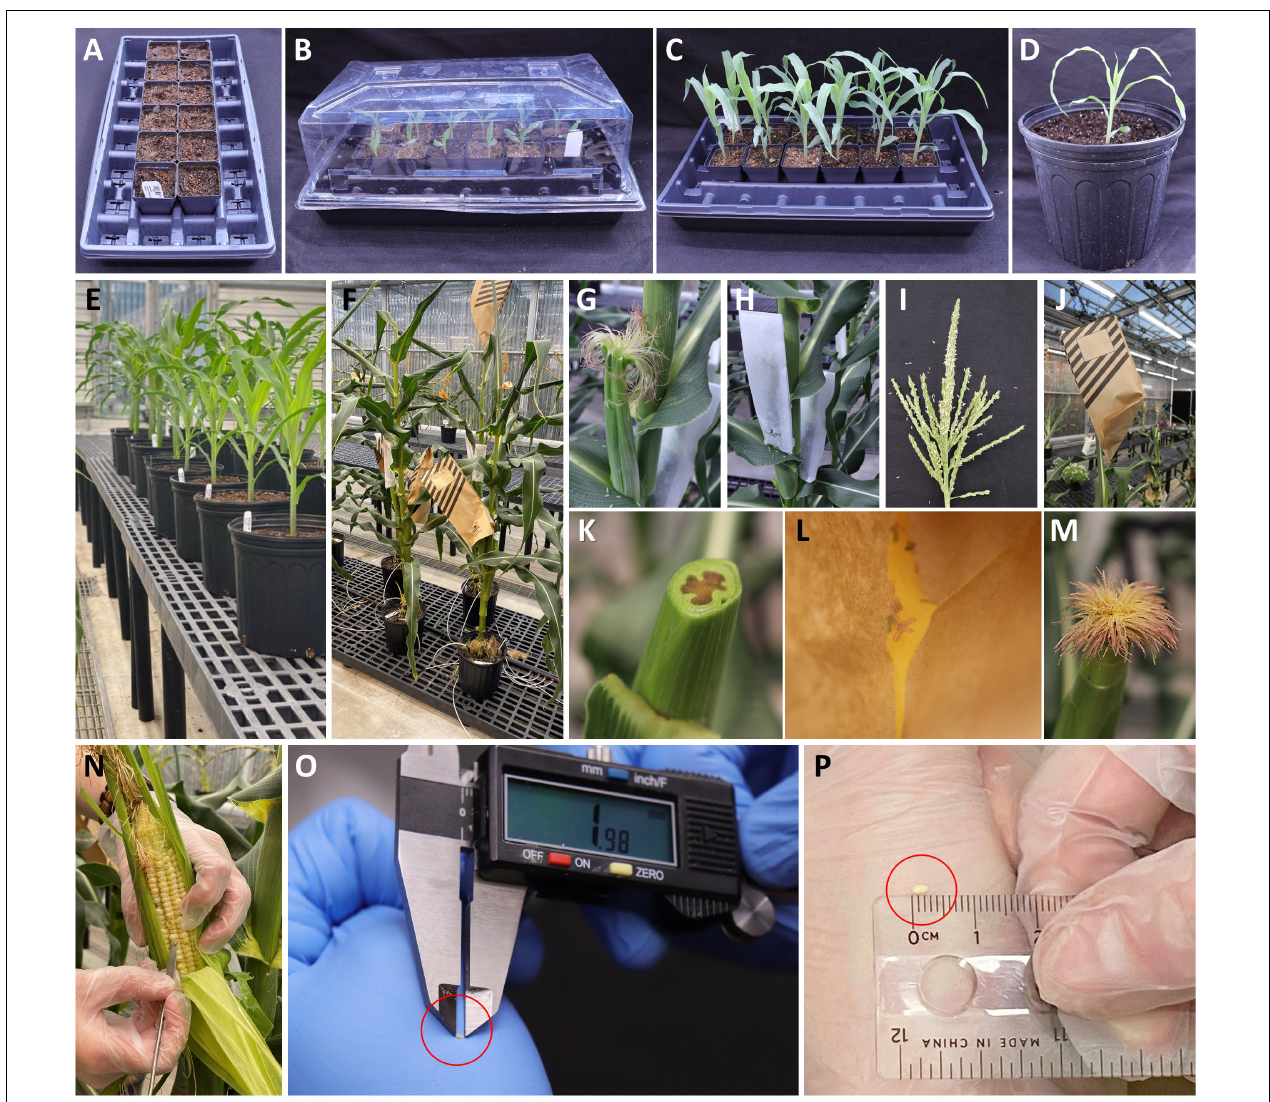
FIGURE 2 | Growing maize donor plants for immature embryo production. (A) Standard flat with small pots filled with potting mix for planting maize seed. (B) Six-day-old germinated seedlings under a humi-dome. (C) Two-week-old seedlings ready to be transplanted into large pots. (D) A seedling transplanted to a large pot. (E) Plants on a 1 m tall bench. (F) Pollinated mature B104 plants on the floor. (G) An un-pollinated B104 ear (female flower) with emerged silks. (H) A shoot bag covering an un-pollinated B104 ear. (I) A mature tassel (male flower) ready to be used for pollination. (J) A pollination bag covering a mature tassel for the purpose of collecting fresh pollen. (K) An un-pollinated B104 ear with cut silks. (L) Freshly collected pollen in a tassel bag. (M) Freshly pollinated silks, 1 day after silks were cut. (N) Extracting an immature embryo for measurement while the ear is still growing on the plant. (O) Measurement of an embryo size with a caliper. (P) Estimate of an embryo size with a